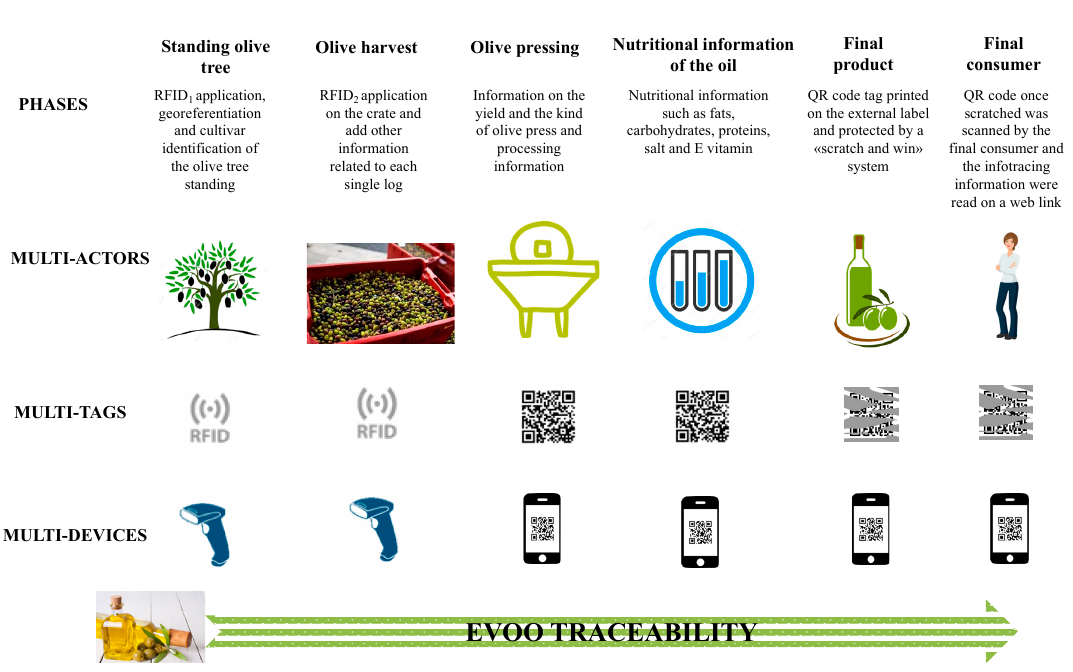
Figure 2. ( A ) The RFID1 standard used is UHF at 860 MHz, Class 1 Gen 2, waterproof coin shaped with central hole; ( B ) the RFID2 is UHF at 860 MHz, waterproof flexible band with two holes at the extremities fixed with a small cord on the crate.